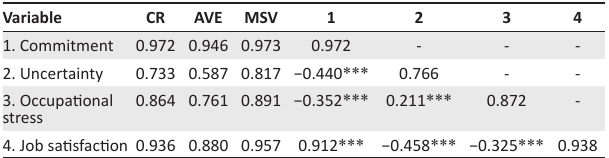
TABLE 4: Validity and reliability.